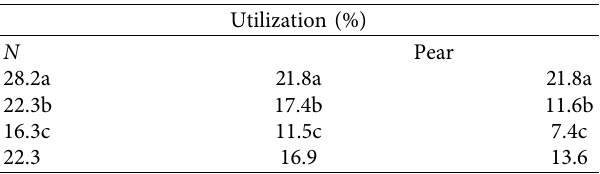
Table 1: 15 N absorption and utilization rate of aboveground parts treated with different markers.